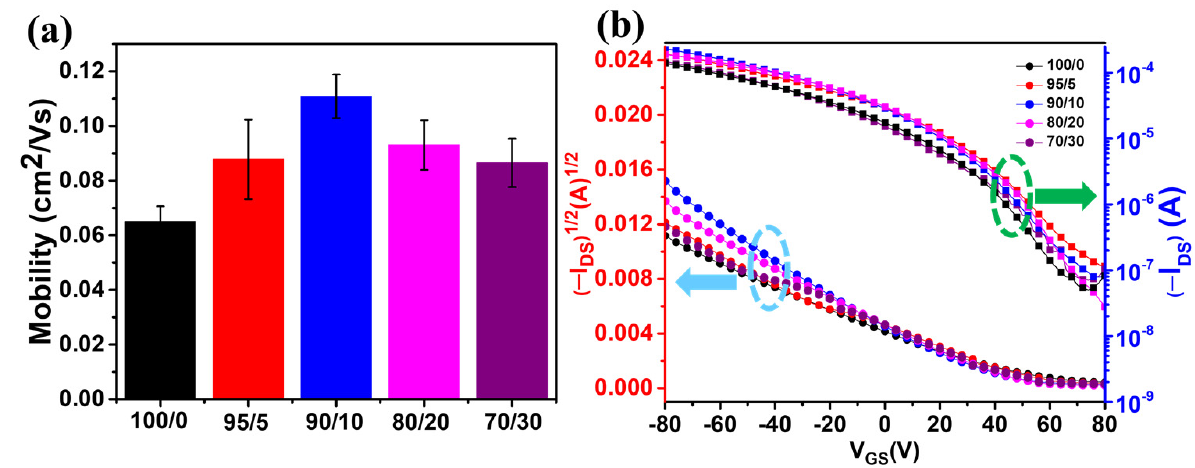
Figure 6. Comparison of ( a ) average charge carrier mobilities and ( b ) typical transfer curves of the bare P3HT (100/0), P3HT/g-C ₃ N ₄ (95/5), P3HT/g-C ₃ N ₄ (90/10), P3HT/g-C ₃ N ₄ (80/20), and P3HT/g- C ₃ N ₄ (70/30) OFETs.